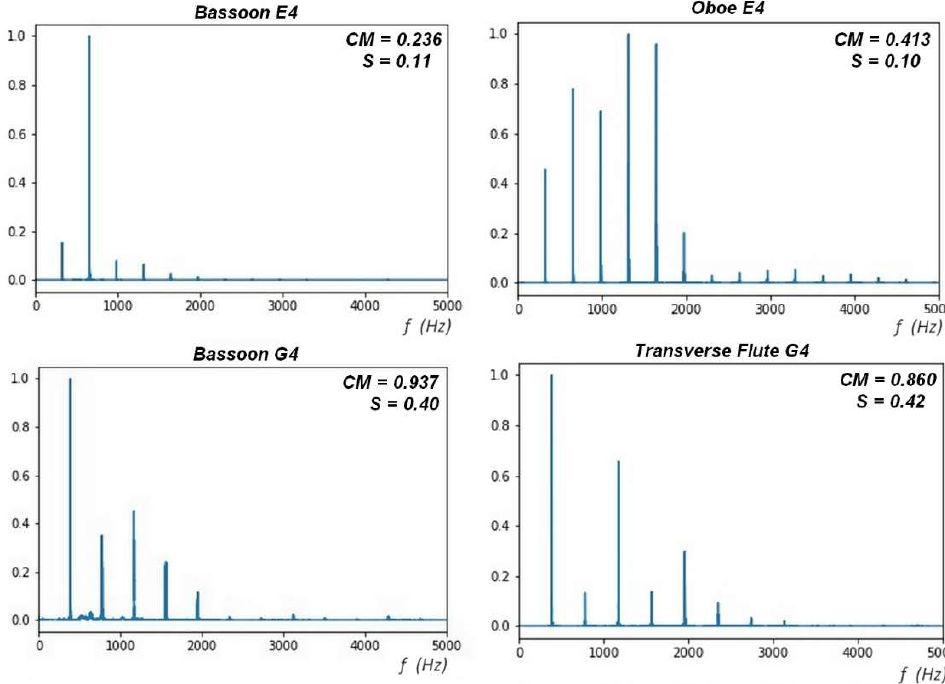
The Mean Contrast ( MC ) is the coefficient that measures the amplitude of the partial frequencies (tones or “colors”) concerning the fundamental frequency.